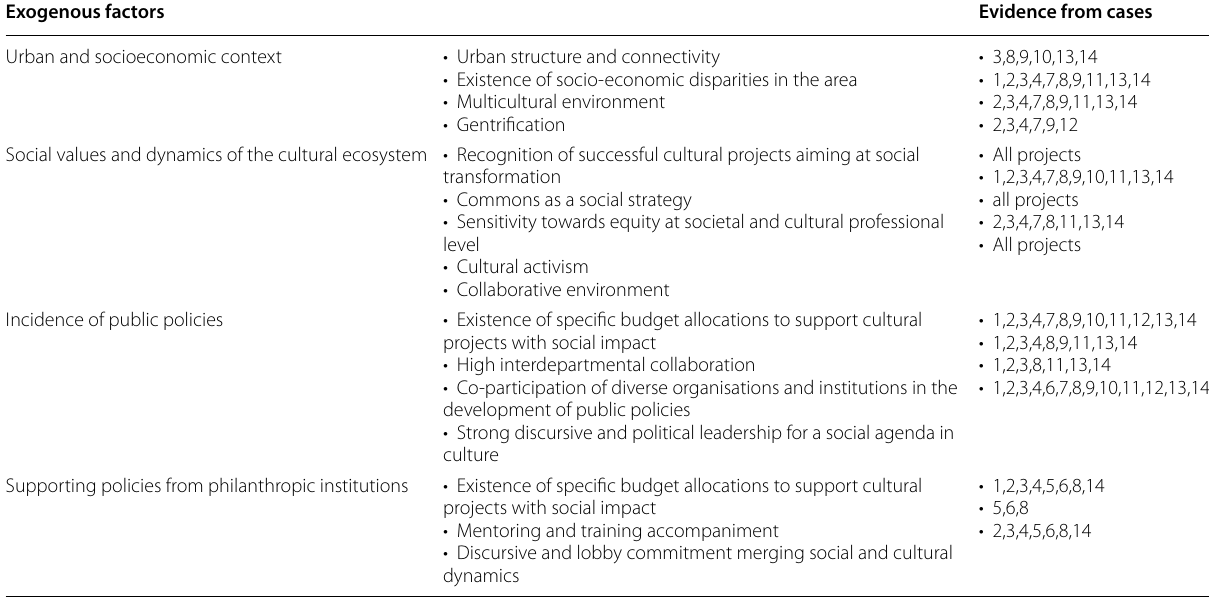
Table 2 Exogenous factors Exogenous factors Evidence from